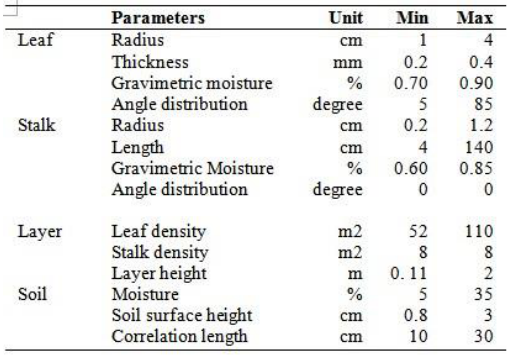
Table 1. Experimental data of